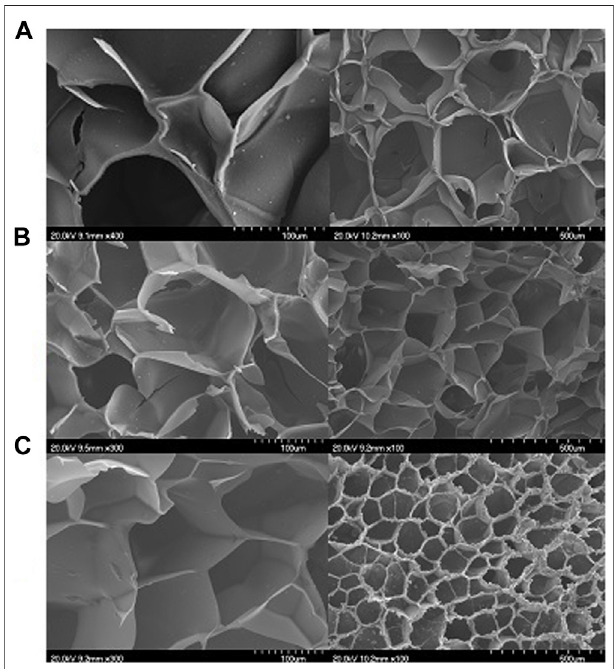
FIGURE 1 | The morphology of the (A) Gel, (B) Gel-HNT and (C) Gel- HNT/ZA scaffolds.